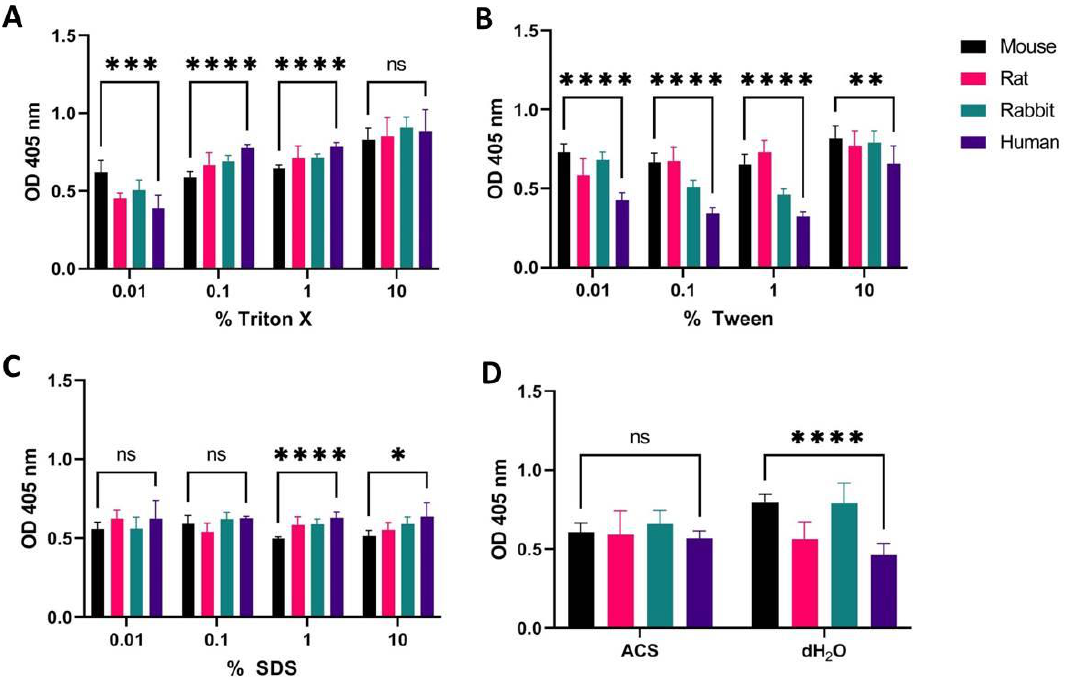
Figure 5. OD measurements at 405 nm (Y-axis) of free hemoglobin in a 1% erythrocyte solution sourced from a mouse, rat, rabbit, and human treated with different concentrations of Triton X-100 ( A ), Tween ( B ), and SDS ( C ), as well as ACS or dH 2 O ( D ). Erythrocytes were incubated for 60 min at 37 ◦ C. Average values from three experimental replicates, each containing two technical replicates, are presented with error bars (SD) included in plots. Significantly different data as defined from unpaired t -test is indicated by asterisks ( p -values: * < 0.05 ** < 0.01 *** < 0.001 **** < 0.0001 ns: non- significant).